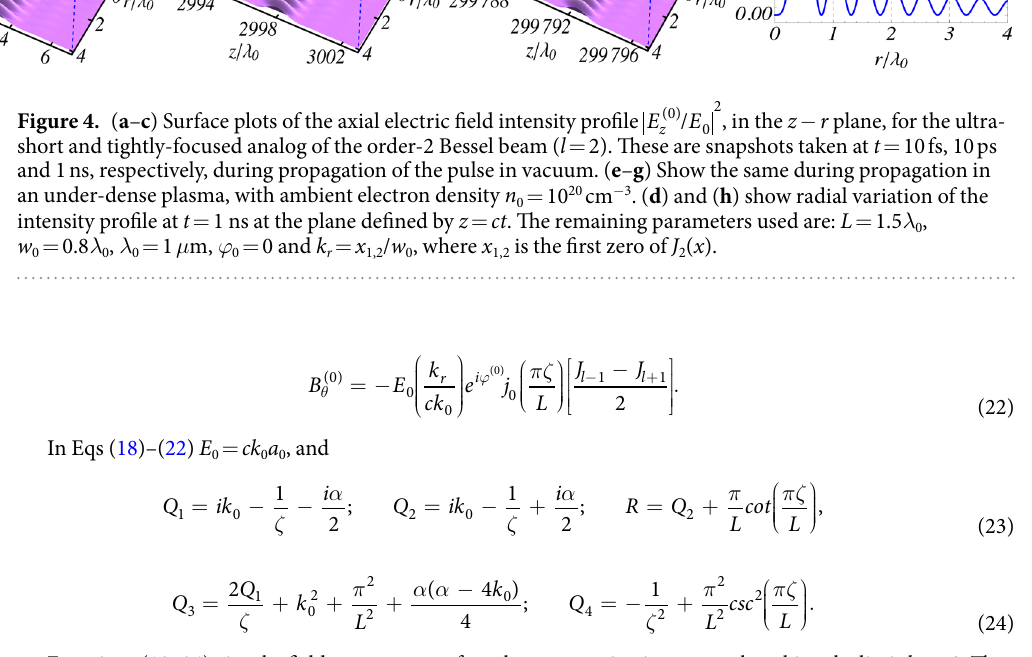
According to Eq. (25) the wavevector does not have a radial component and wavefronts (surfaces of constant phase) are helices of fixed radii r . In this sense the bullet carries orbital angular momentum, with the index l labeling different states in the relevant Hilbert space 42 . In general, an effective frequency for the bullet may be obtained from